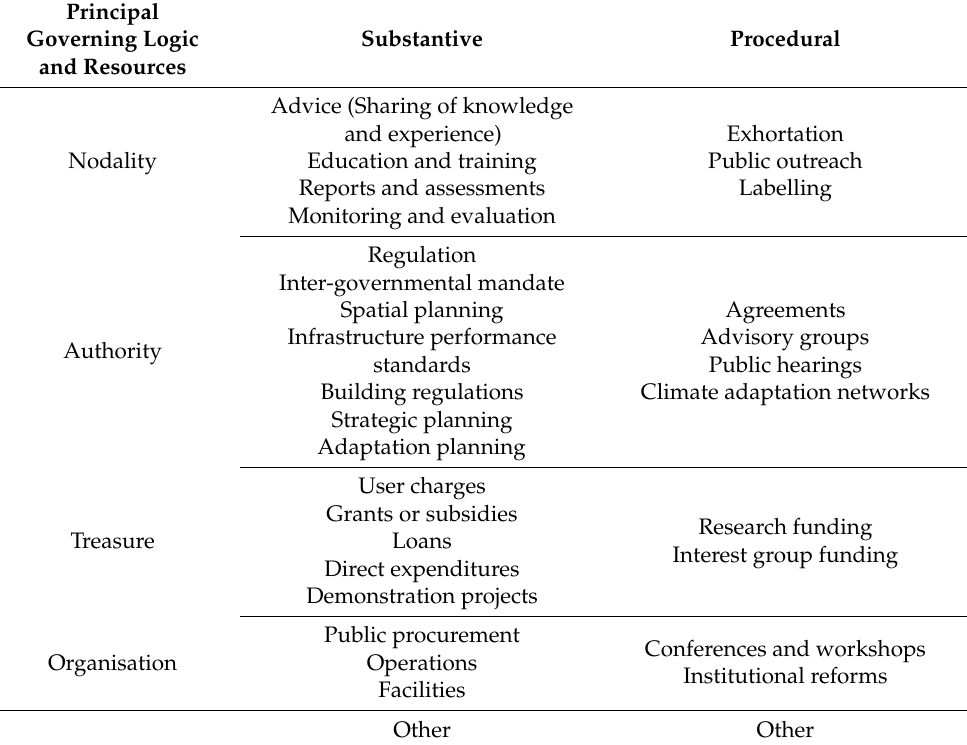
Table 2. Types of adaptation policy instruments according to governing logic and resources